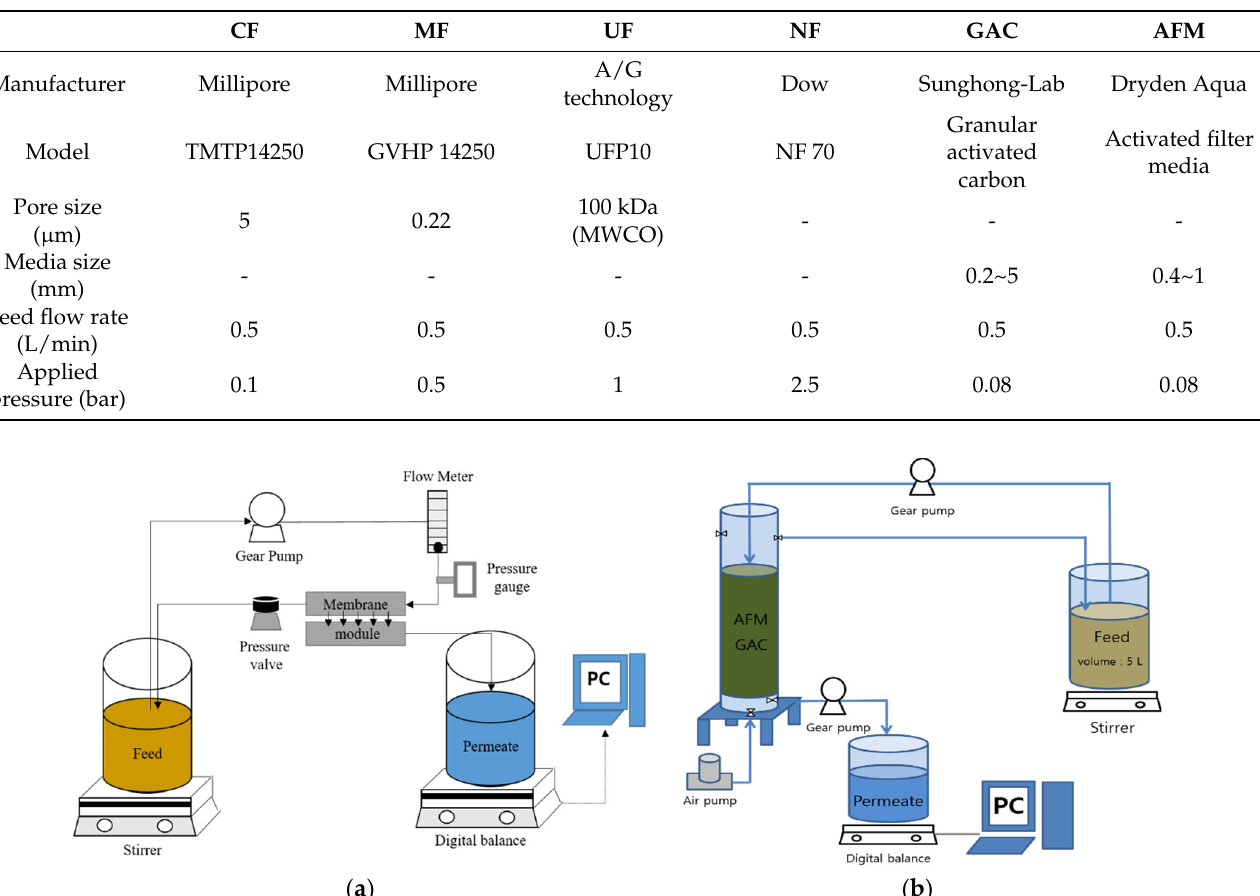
Table 3. Summary of pretreatment methods.